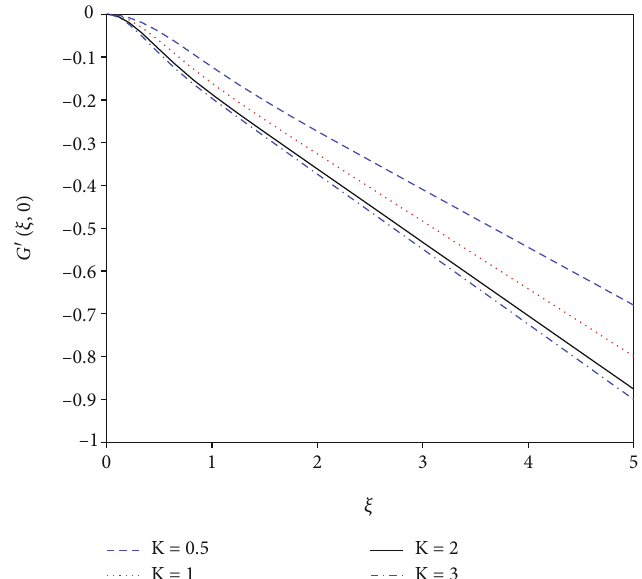
Figure 16: Development of the rate of the gyration component at the wall G ′ ð ξ , 0 Þ for di ff erent values of vortex viscosity parameter K , when n = 0, ξ = 5, Pr = 10, and S = N = He = Ω = 0 R